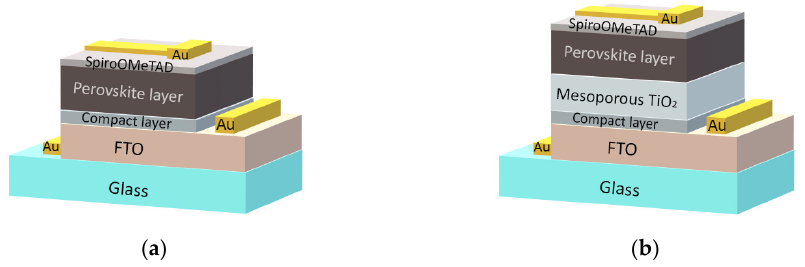
Figure 1. Schematic configuration of the cells fabricated for the study: ( a ) without porous TiO 2 layer, ( b ) with porous TiO 2 layer. The compact TiO 2 layers with and without Nb 2 O 5 were formed using the ALD and spray pyrolysis methods, respectively.